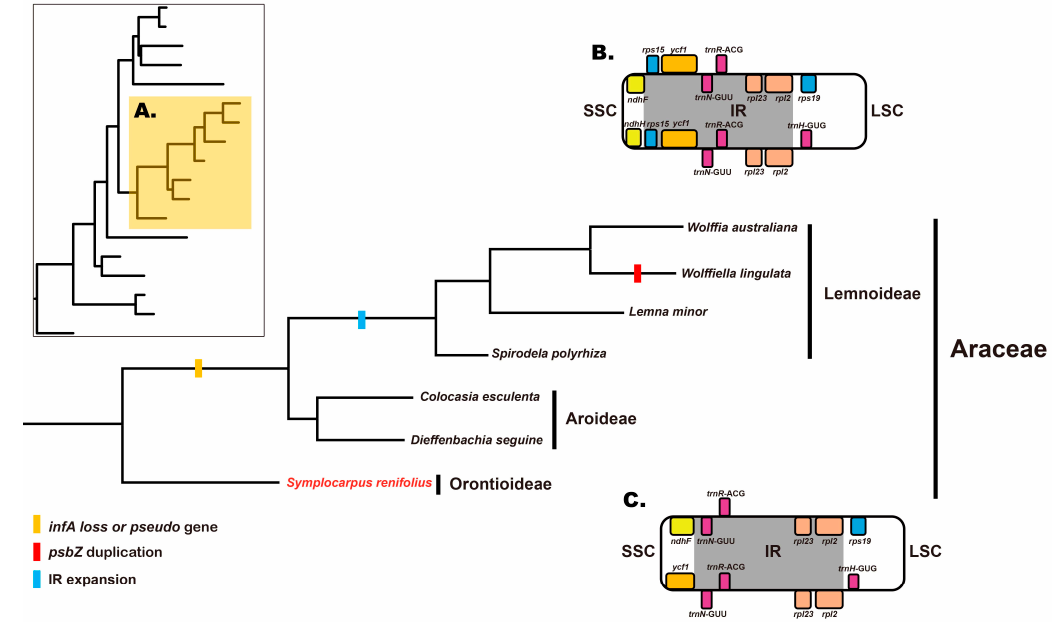
Figure 8. Gene duplication, gene loss and IR expansion in Araceae. ( A ) Phylogenetic position and gene contents in Araceae species; ( B ) IR junction expansion and gene duplication in Lemnoideae; ( C ) IR junction in Aroideae and Orontioideae.